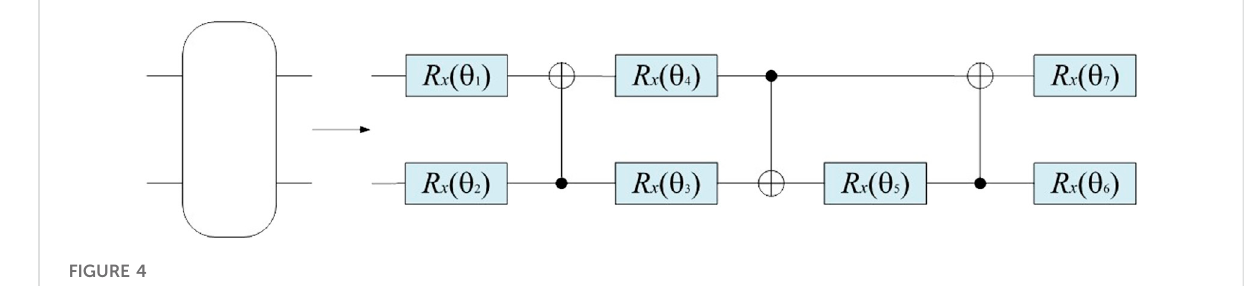
FIGURE 4 Two-qubit gate.